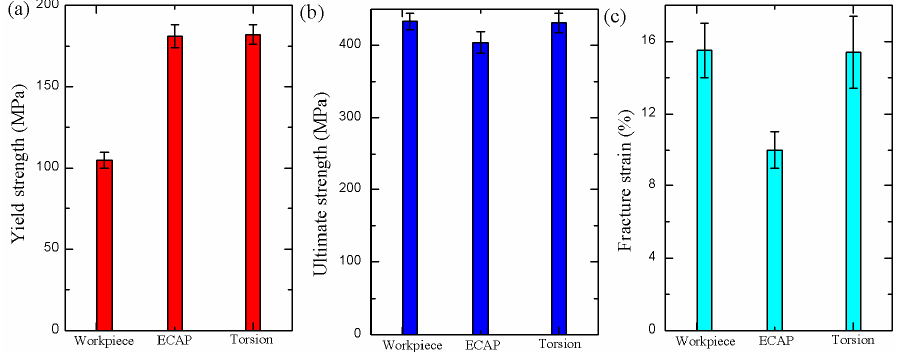
Figure 4. Comparisons of mechanical properties of AZ31B processed by different deformation modes: ( a ) yield strength; ( b ) ultimate strength; ( c ) fracture strain.